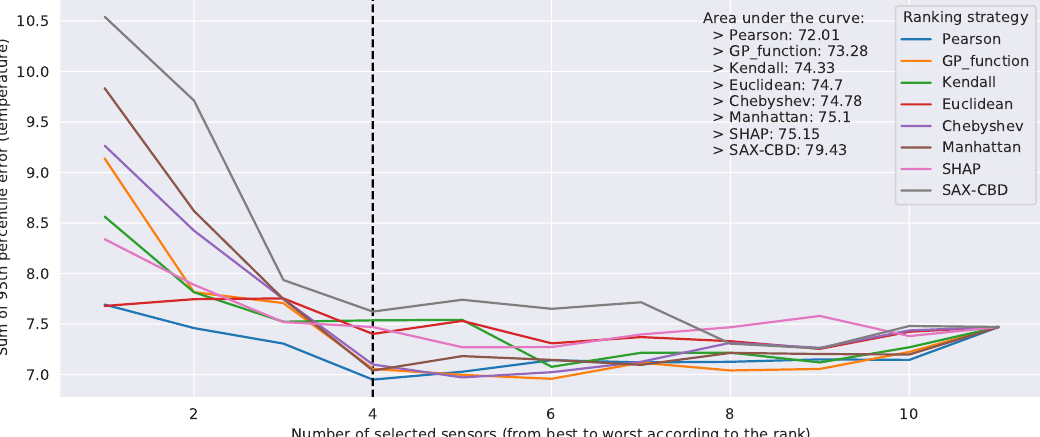
Figure 9. Performance of linear regression, evaluated discarding sensors based on training set ranks. The dashed vertical line represents the elbow of the Pearson error